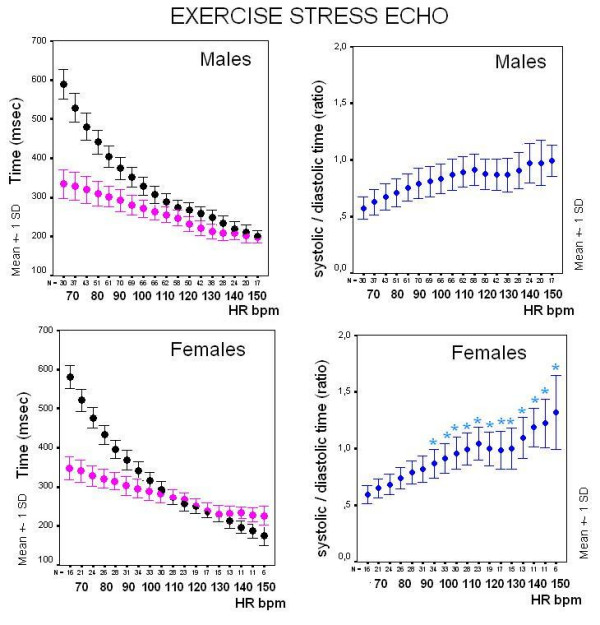
Exercise stress, males vs. females. Plot of systolic (pink symbols) and diastolic (black symbols) mean ± SD time values at increasing heart rates during exercise stress in males (upper panels) and females (lower panels). Despite similar prevalence of controls vs. heart diseases patients in both subgroups, females show lower diastole duration at peak stress.